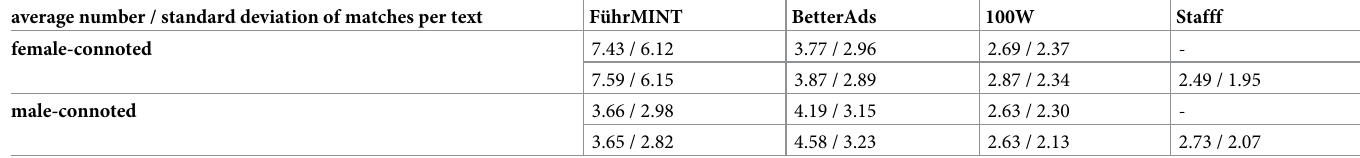
Table 4. Average number and standard deviation of matched expressions, split by category (female-/male-connoted), technology and data sample (first and second row representing the large and small data sample, respectively). average number / standard deviation of matches per